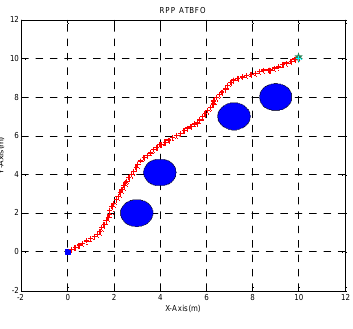
Fig. 5. Best shortest path for case 1.